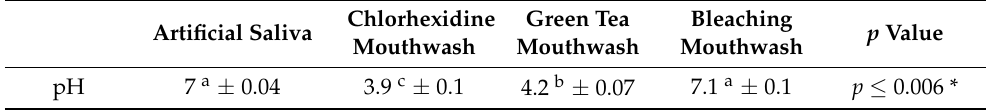
Table 2. The pH of artificial saliva and different